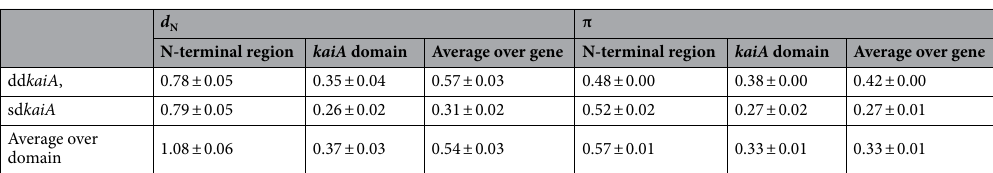
Table 2. Patterns of nucleotide diversity in the kaiA homologs of cyanobacteria. The rate of synonymous nucleotide substitutions ( d S ) was not estimated due to saturation.